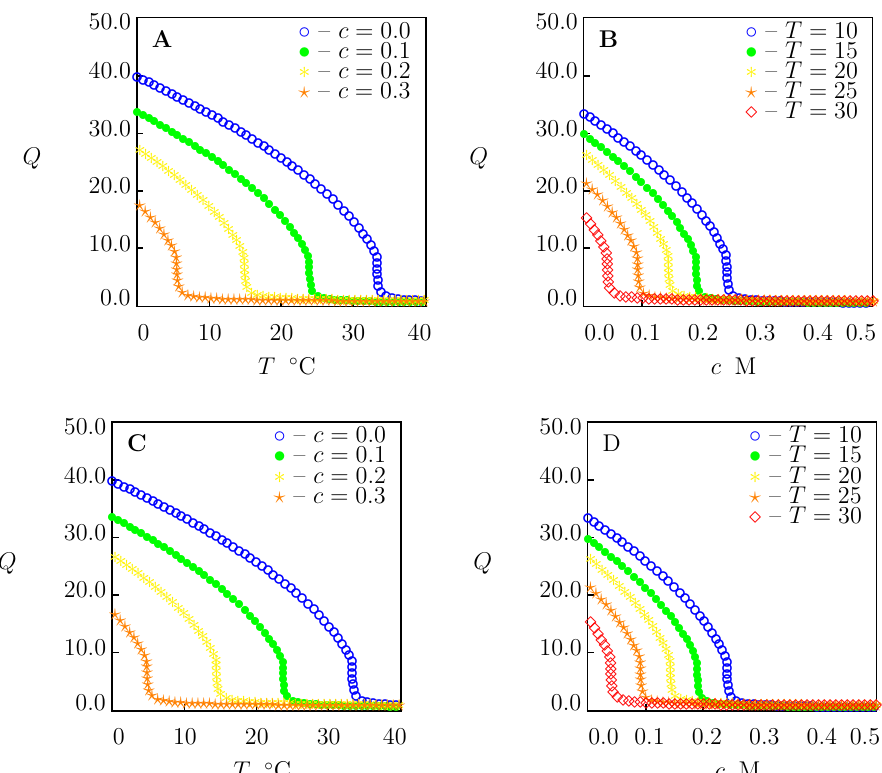
Figure 11. ( A , C )—Equilibrium degree of swelling Q versus temperature T . ( B , D )—Equilibrium degree of swelling Q versus concentration of salt c . Symbols: predictions of the model for PNIPAAm gel in aqueous solutions of FeCl 3 ( A , B ) and AlCl 3 ( C , D ) with various concentrations c M at various temperatures T ◦ C.